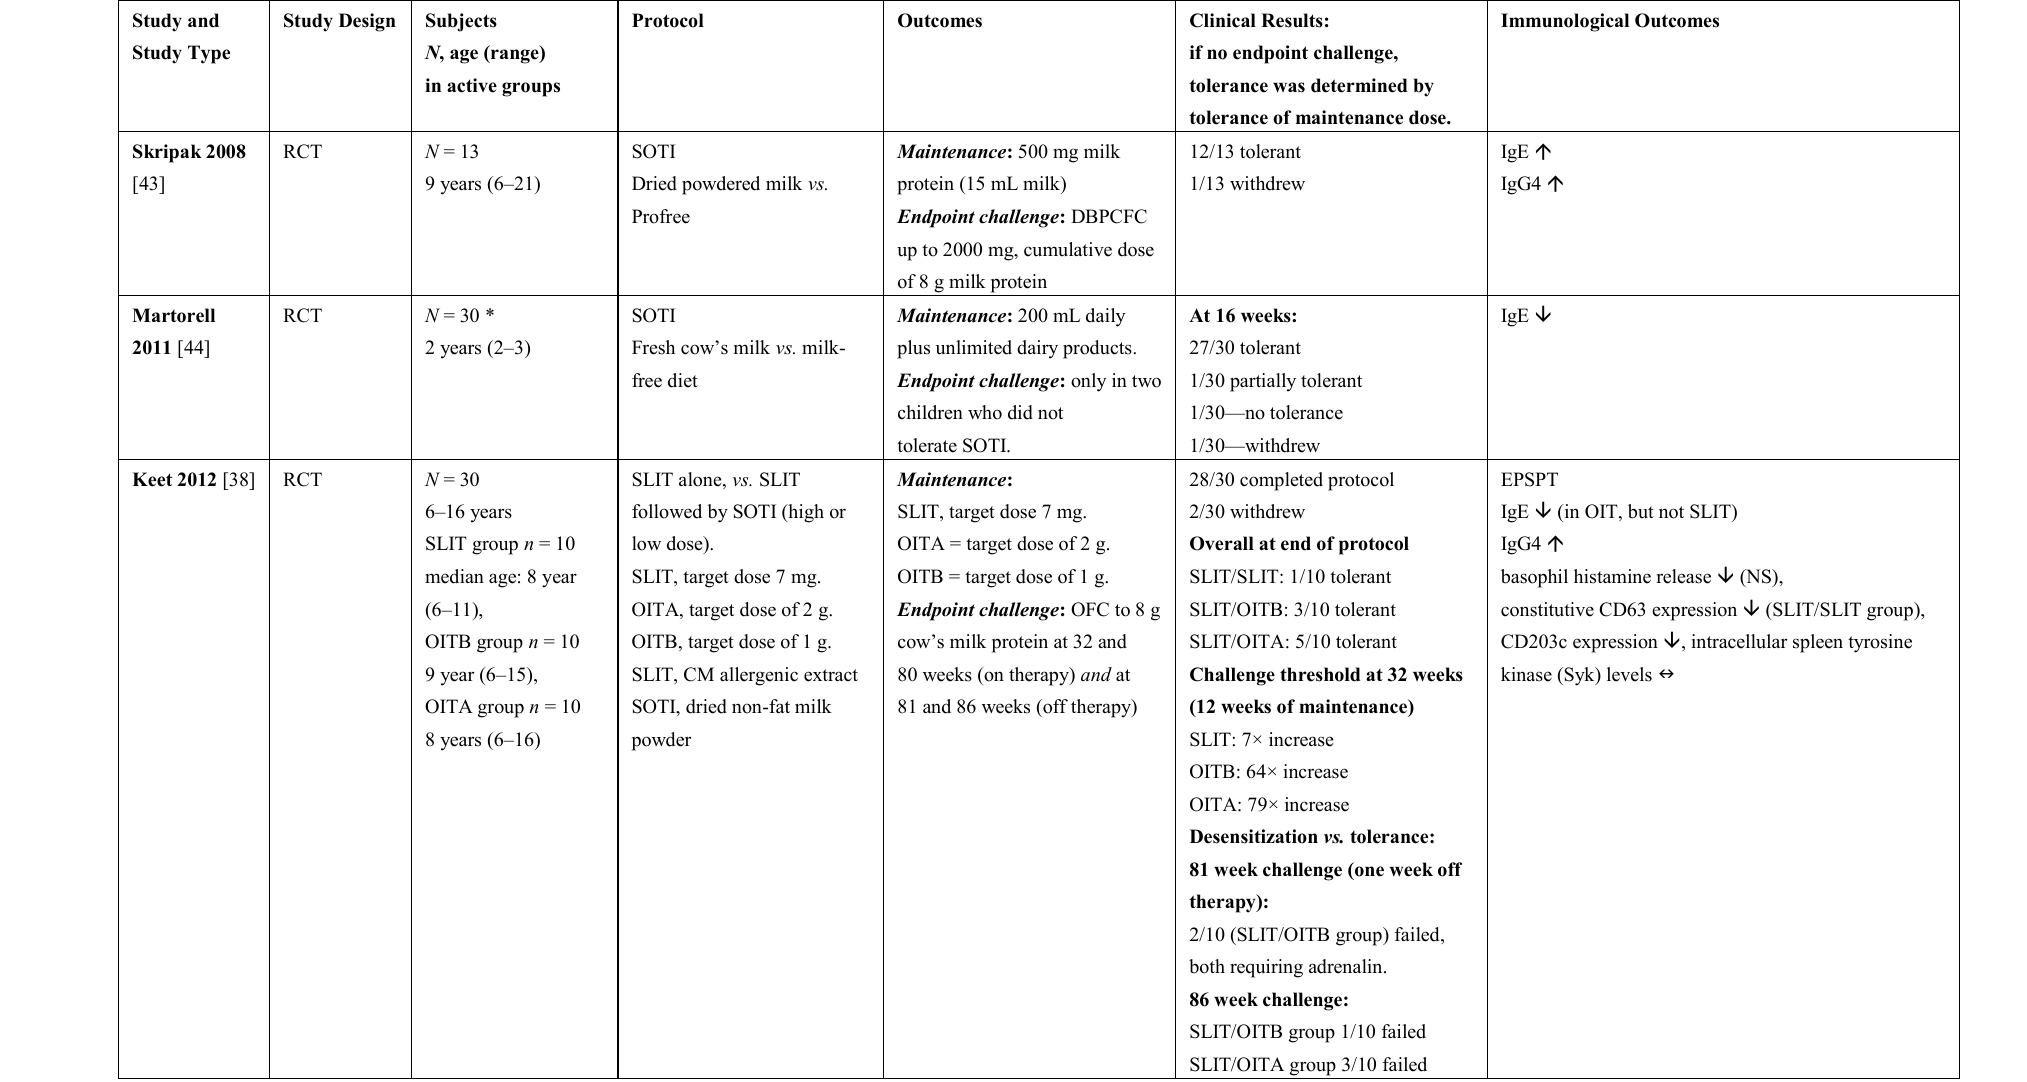
Table 2. Summary of key cow’s milk specific oral immunotherapy